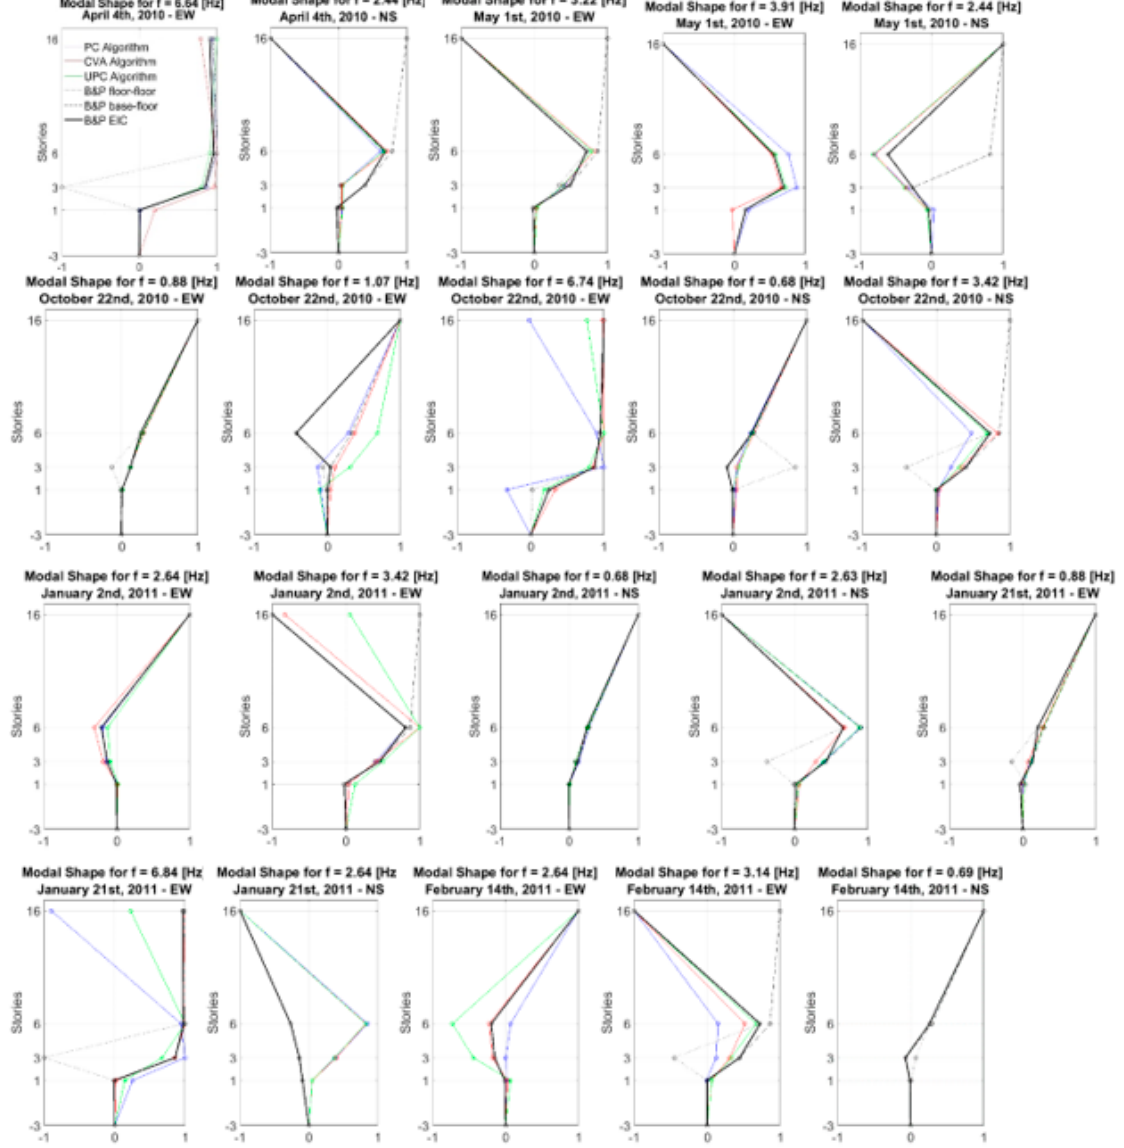
Figure 9. Vibration mode shapes for the translational frequencies of the earthquakes that occurred between 4 April 2010, and 14 February 2011, in the east-west and north-south directions. The blue, red and green curves correspond to the PC, CVA and UPC algorithms, respectively, for the parametric method. The black dotted and segmented curves correspond to the floor-floor and base-floor correlations, respectively, proposed by Nandagopalan et al. [29]. Finally, the thick continuous black lines correspond to the calibrated correlations corresponding to the base-floor correlation up to floor 3 and the floor-floor correlation for floors 6 and 16. This correlation is referred to as Bendat and Piersol EIC.